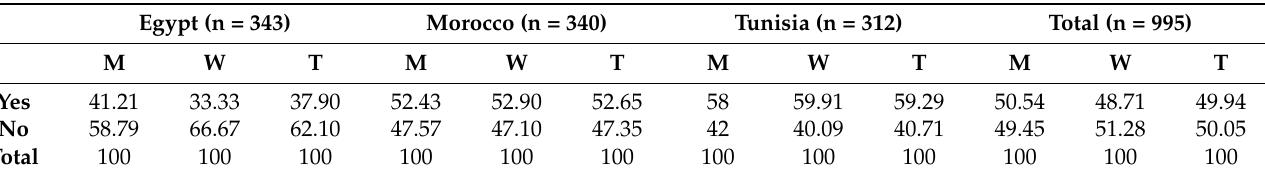
Table 6. Food stockpiling behavior (percentage) (n = 995).